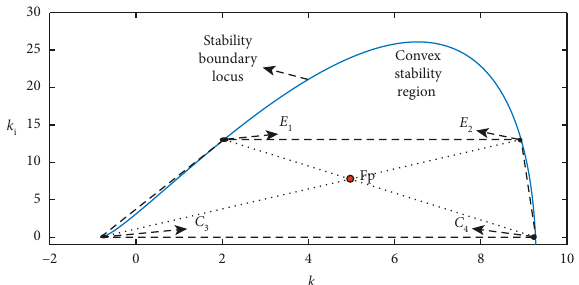
Figure 19: Regular convex stability region and Fermat point of PI controller in example E.